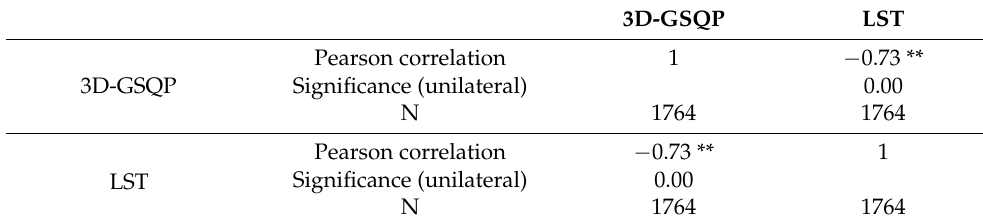
Table 7. Correlation analysis between 3D-GSQP and